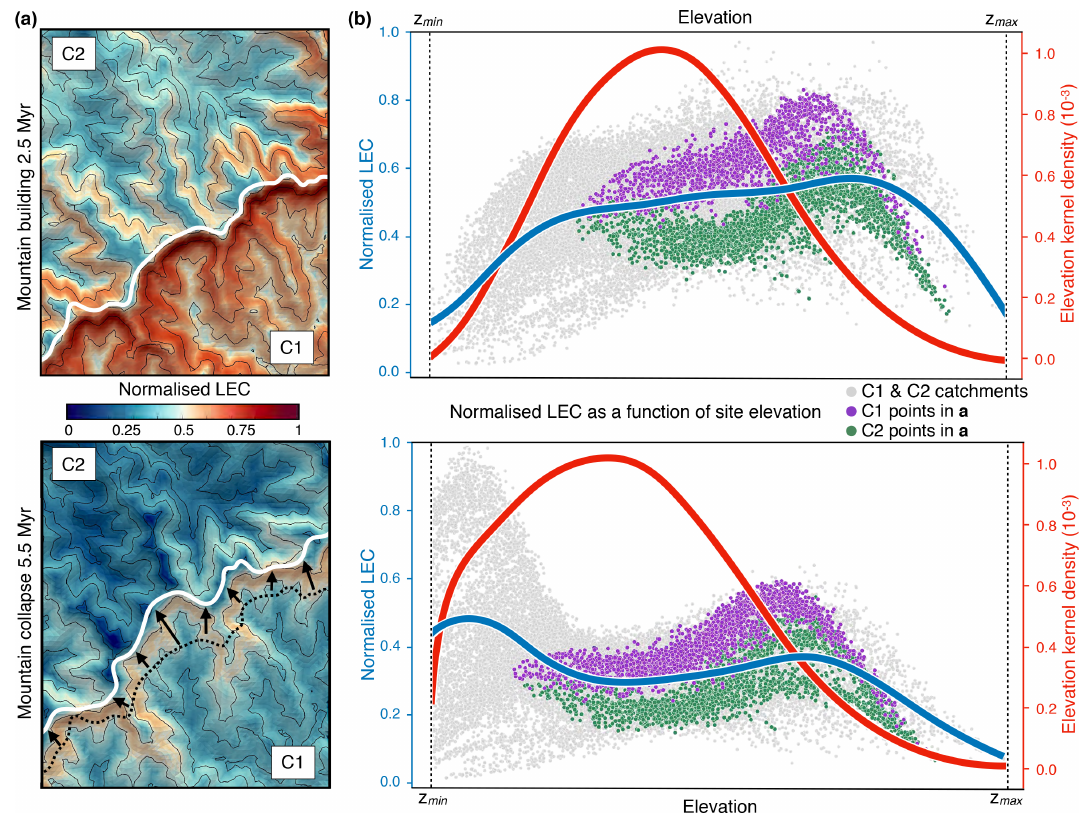
Figure 5. Temporal evolution of normalised LEC distribution patterns between windward (C1) and leeward (C2) catchments sharing a common divide (region B defined in Fig. 4c). (a) Normalised connectivity maps at 2.5 and 5.5Myr; the white line represents the drainage- divide position at the current time step. The black dotted line shows the divide position at 2.5Myr and black arrows its migration direction. Contour lines are defined every 250m and range between 500 and 1750m. (b) Plots of normalised LEC (grey dots), the average line of LEC within elevational bands (blue lines), and elevation kernel density (red lines) for the entire simulated domain at chosen time intervals. Normalised LEC for points belonging to the windward and leeward catchments (C1 and C2, respectively) are highlighted. The normalised LEC exhibits a typical pattern, with higher values and broader ranges during the mountain-building phase at middle to high